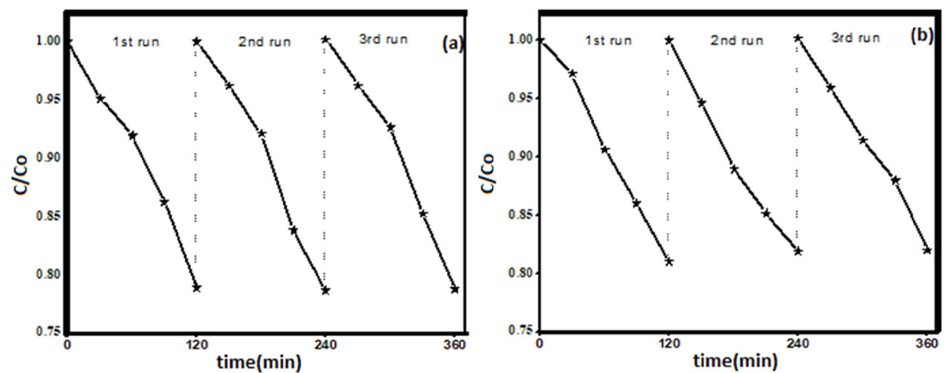
Figure 9. ( a ) Cyclability test of TiO 2 -FG/Sr-hexaferrites using MB degradation; ( b ) cyclability test of TiO 2 -FG/Sr-hexaferrites using Rh. B.